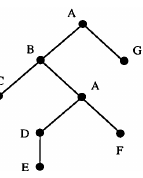
Figure 6: Hierarchy over AP-Dimension treatment